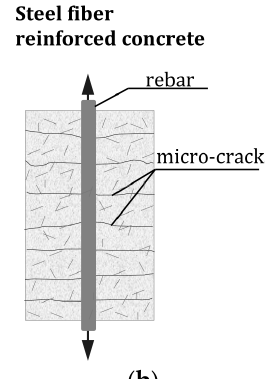
Figure 1. Examples of steel fibers used for concrete reinforcement [own study].